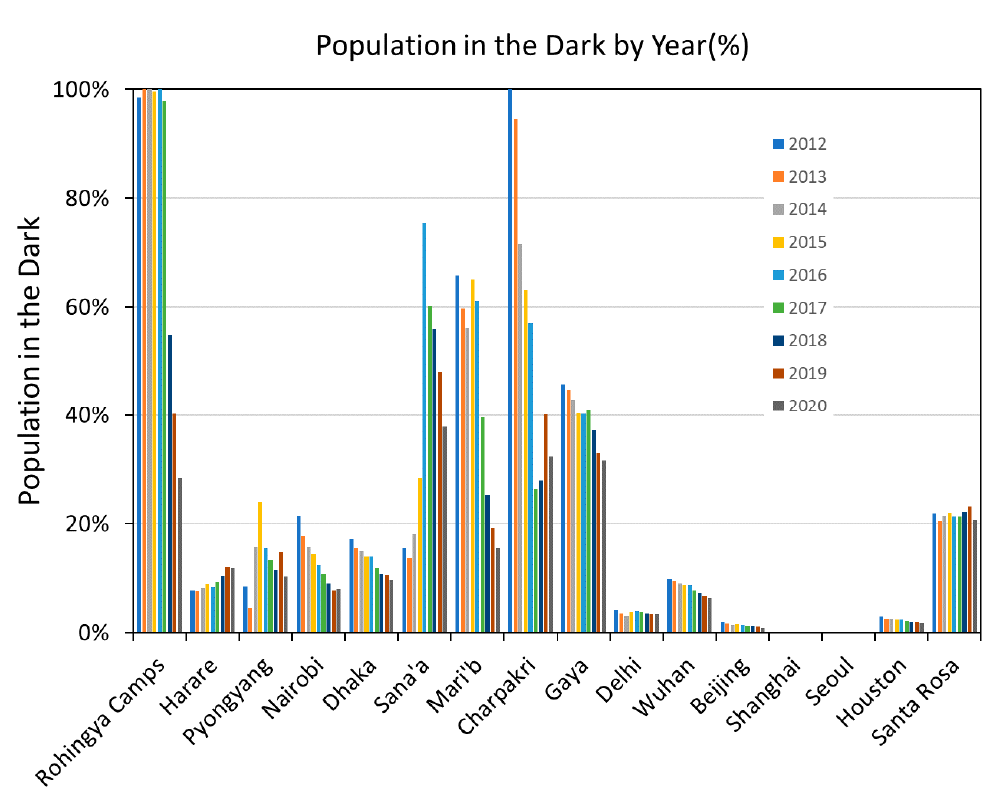
Figure 42. Percent of population in the dark by year.